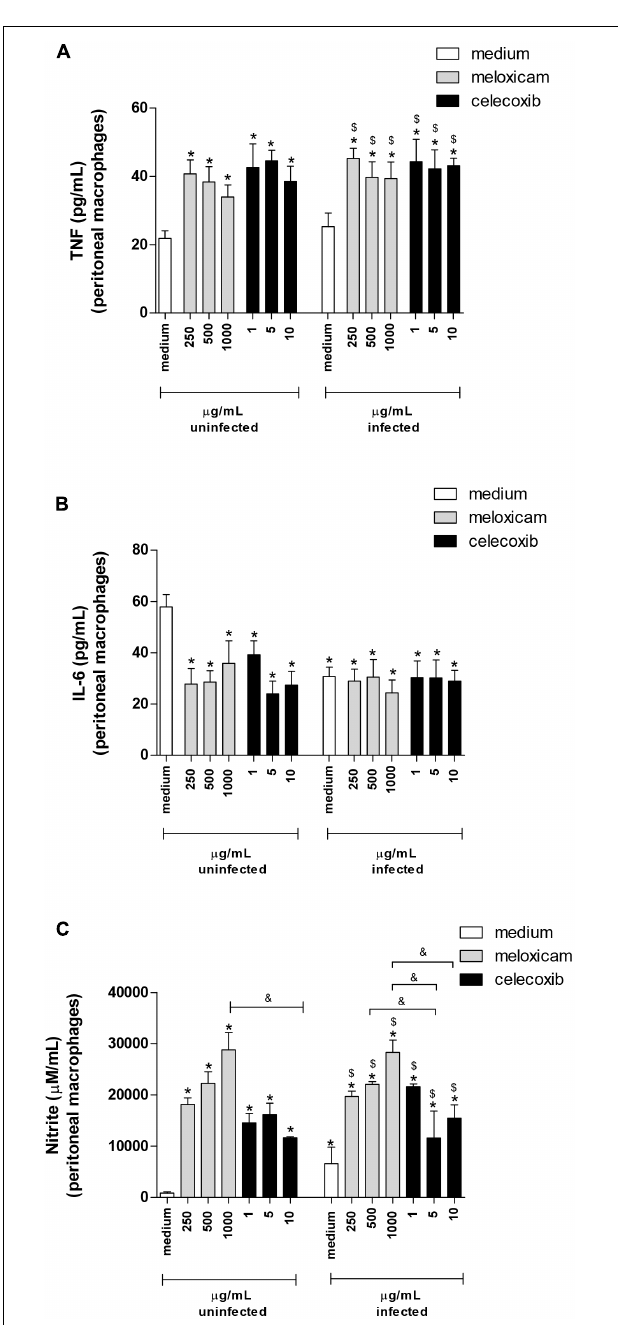
FIGURE 5 | Cytokine and nitrite production in C. callosus -peritoneal macrophages treated with COX-2 inhibitors. Peritoneal macrophages were seeded in 96-well plates (1 × 10 5 cells/200 µ L) for 24 h, infected or not with T. gondii tachyzoites (2F1 clone, RH strain), treated or untreated with meloxicam or celecoxib for additional 24 h and the supernatants collected for measurement of TNF (A) and IL-6 (B) by sandwich ELISA, or nitrite (C) by the Griess method. Data are shown as mean ± SEM from three independent experiments with six replicates. Differences between groups were analyzed by two-way ANOVA with the Bonferroni post hoc test. Significant differences in relation to untreated/uninfected cells (medium) ( ∗ P < 0.05), untreated/infected cells (medium) ( $ P < 0.05), and different concentrations of COX-2 inhibitors regardless of infection ( & P <